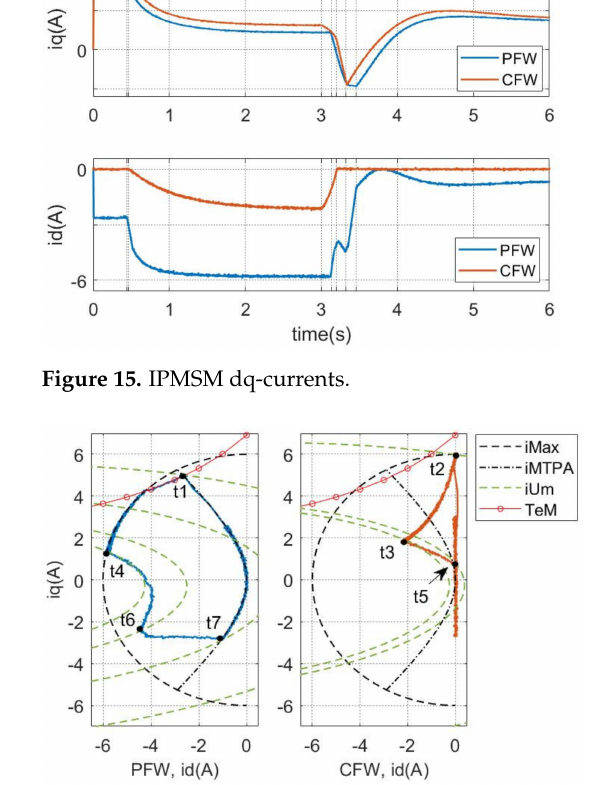
Figure 16. Current trajectory. Left: PFW-MPC (blue), Right: CFW-MPC (orange). iMax: maximum current, iMTPA: MTPA trajectory, iUm: current trajectory of f U = 0, and TeM: maximum electrical torque’s trajectory. t1: 0.44 s, t2: 0.46 s, t3: 3 s, t4: 3.13 s, t5: 3.2 s, t6: 3.32 s, t7: 3.46